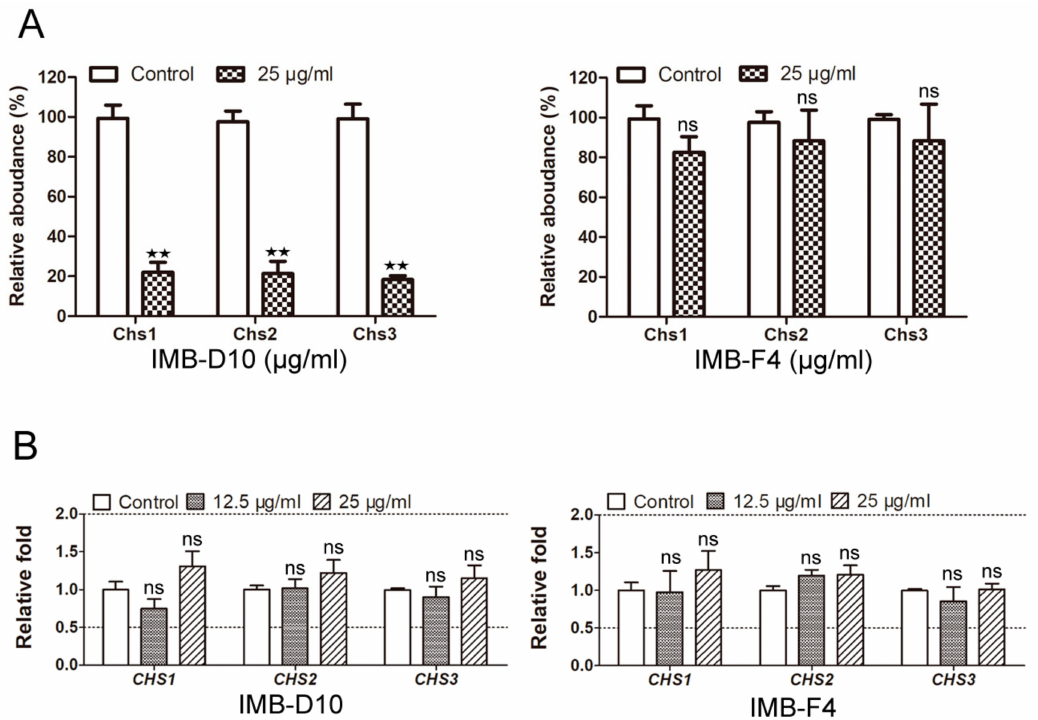
Figure 5. IMB-D10 reduces the protein level of chitin synthases. WT yeast cells were treated with 25 µ g / mL IMB-D10 or IMB-F4 for 16 hours. The cells treated with 0.25% DMSO were used as a control. The genome-wide analysis of the relative protein levels was described in the Material and Methods section. All experiments were performed in triplicate. ( A ) The protein level of the three chitin synthases in yeast cells using isobaric tags for relative and absolute quantification (iTRAQ) technology. p -values were calculated with student’s t -test (mean ± SD; n = 3 ** p < 0.01 and ns: no significant di ff erence vs. Control). ( B ) The expression levels of CHS1 , CHS2, and CHS3 genes were analyzed using the qRT-PCR method. p -values were calculated with one-way ANOVAs (mean ± SEM; n = 3; ns: no significant di ff erence vs.